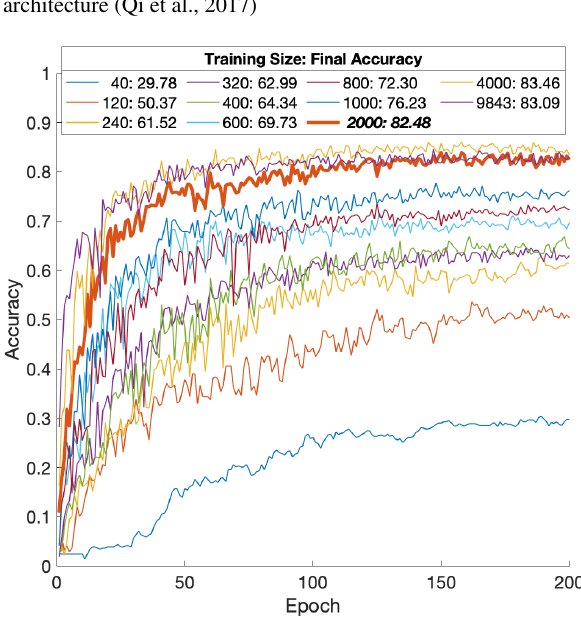
Figure 4. PointNet classification architecture (Qi et al., 2017)